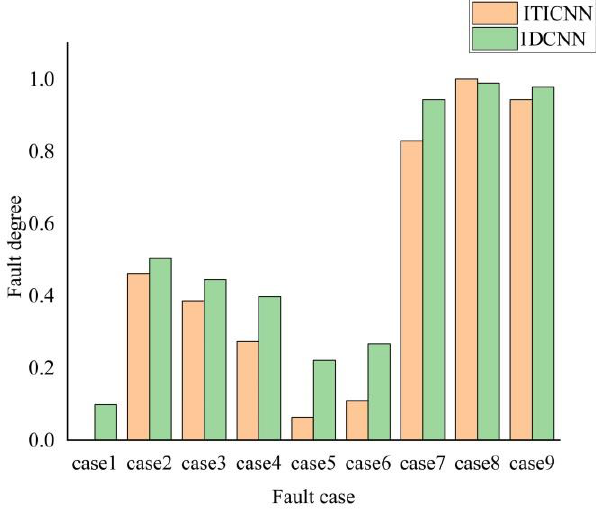
Figure 10. Comparison results between ITICNN and 1DCNN.